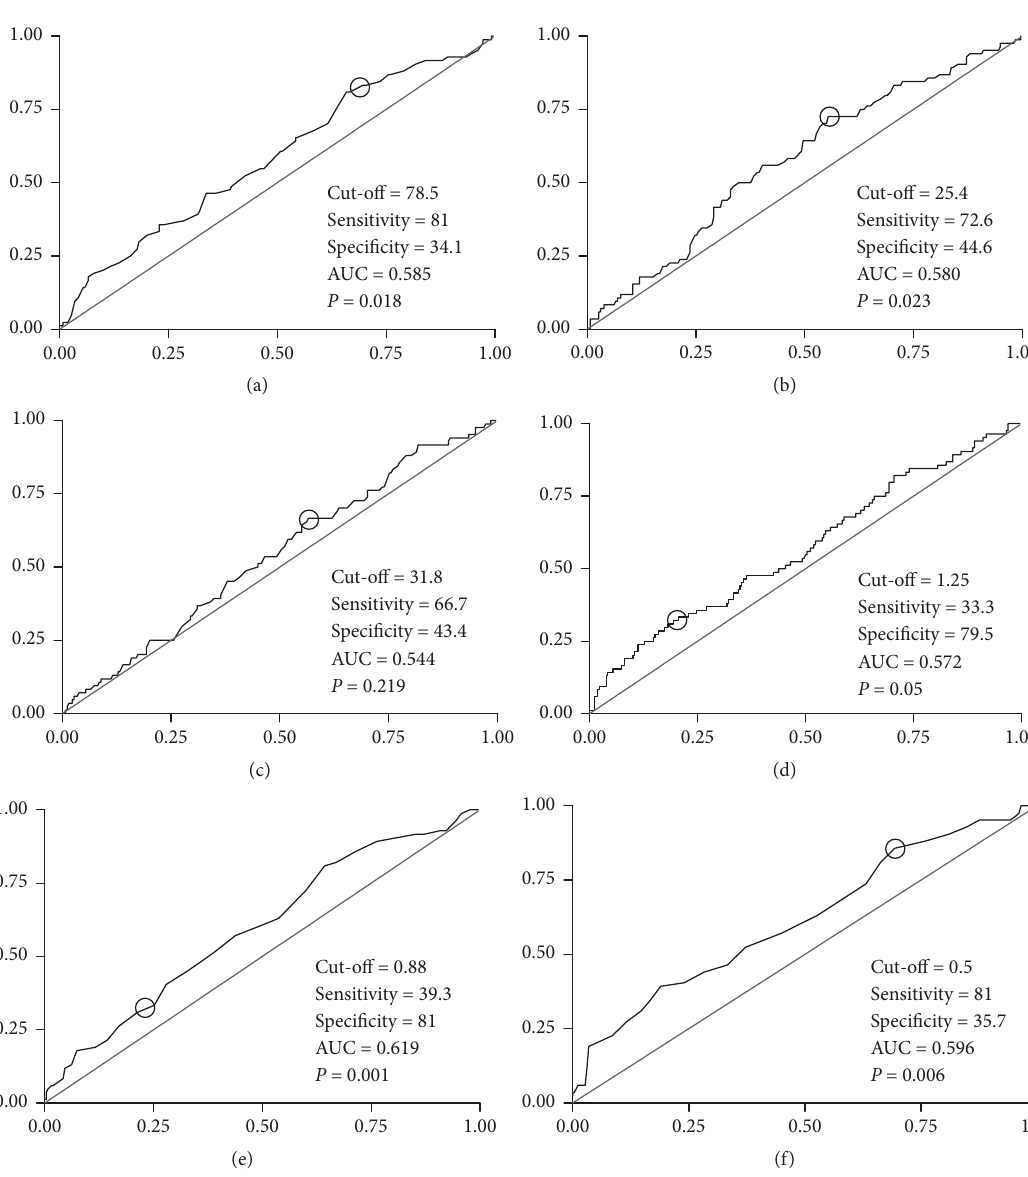
Figure 2: Receiver Operating Characteristic curve according to sensitivity (x-axis) and specificity (y-axis) of (a) waist circumference; (b) body mass index; (c) body adiposity index; (d) conicity index; (e) waist-to-hip ratio; (f) waist-to-stature ratio, in women. AUC: area under the